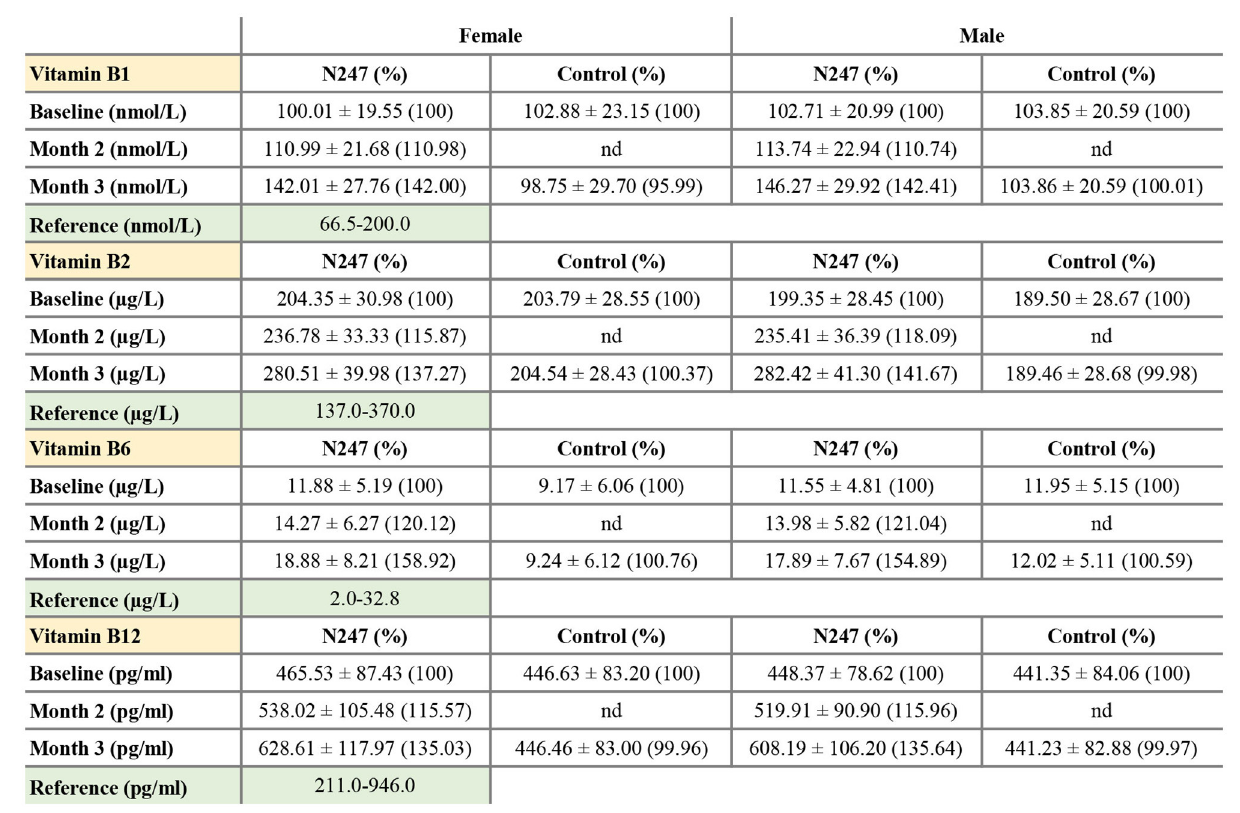
SD% values are given in ±